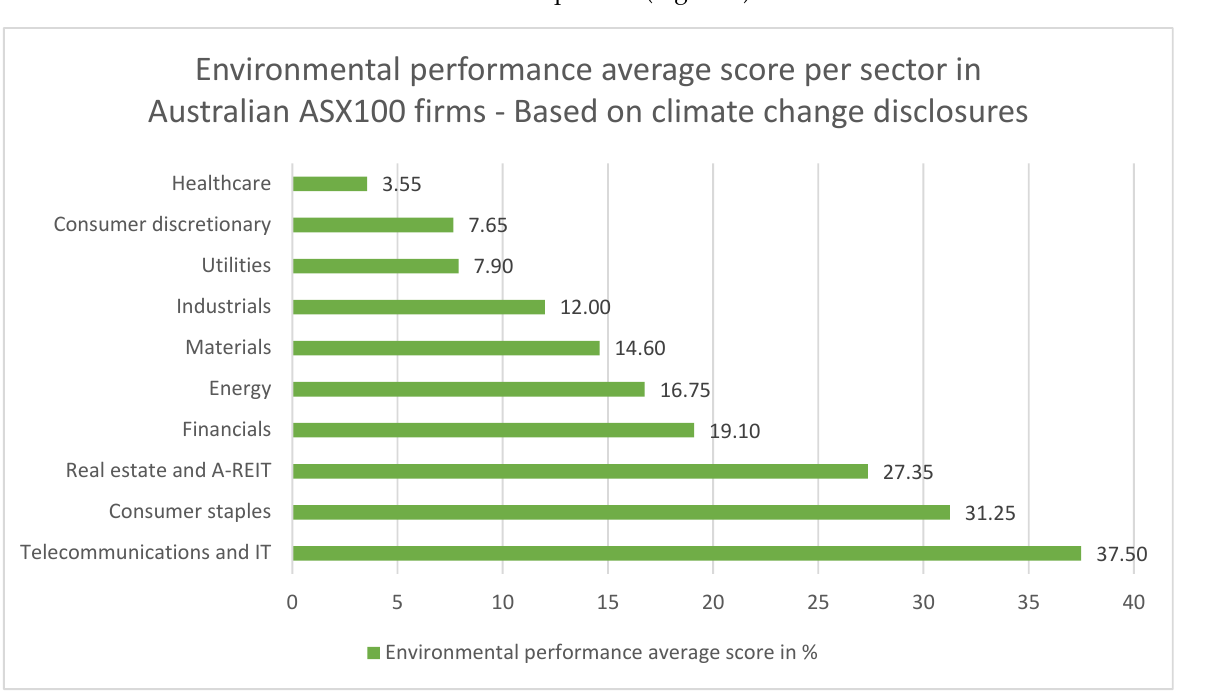
Figure 2. Environmental performance average score per sector in Australian ASX100 firms based on climate change disclosures (source: ACCA, 2011).